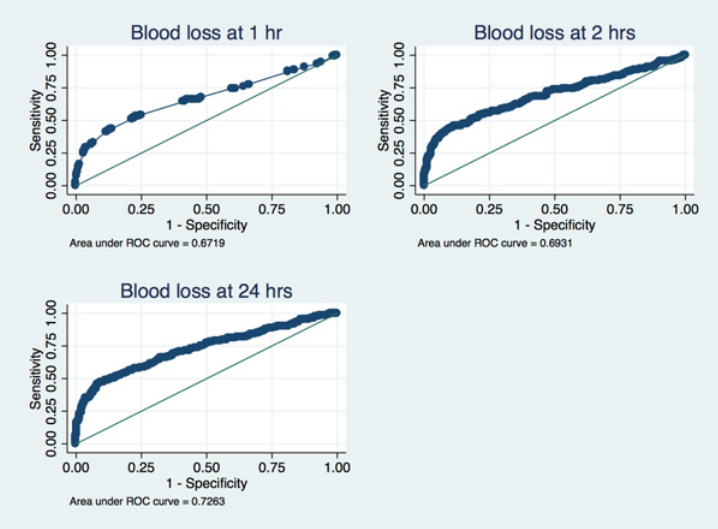
Fig 1. ROC curves comparing measured blood loss and Hb drop (standard) at different time